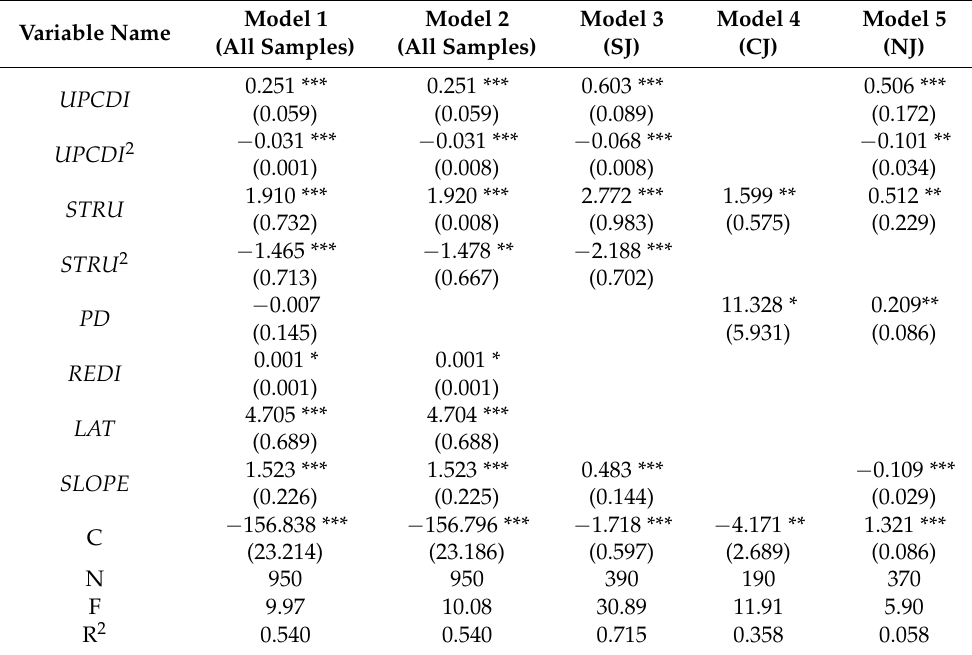
Table 5. Estimated results of the